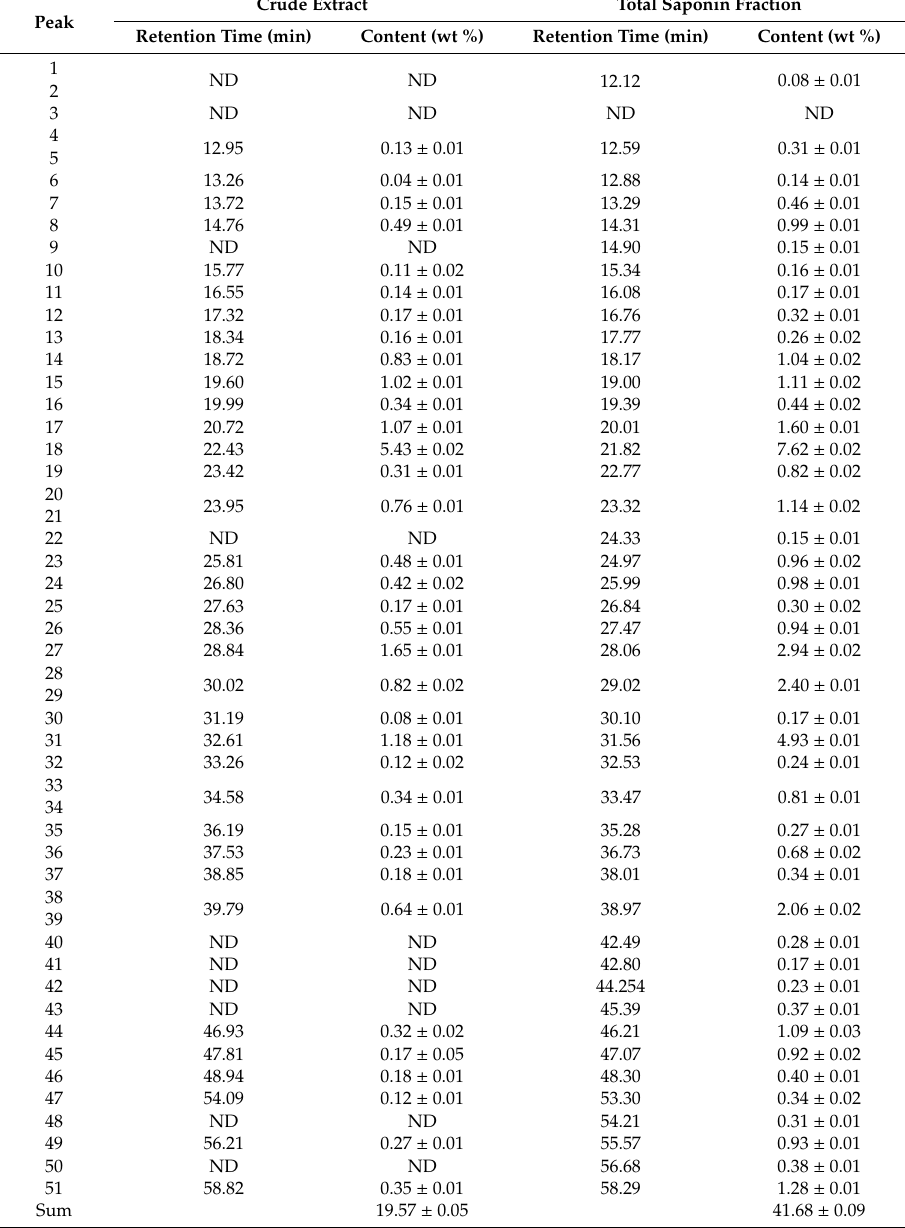
Table 3. Saponin content of the crude extract and total saponin fraction of C. sinensis seeds determined by